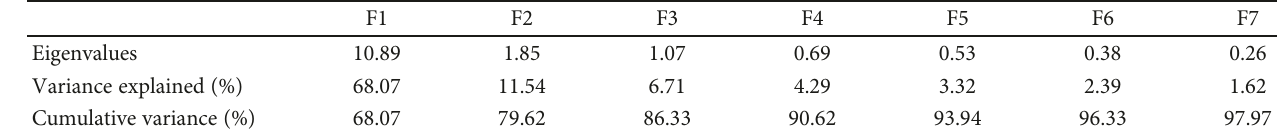
Table 5: Summary of the PCA results including the loadings of the